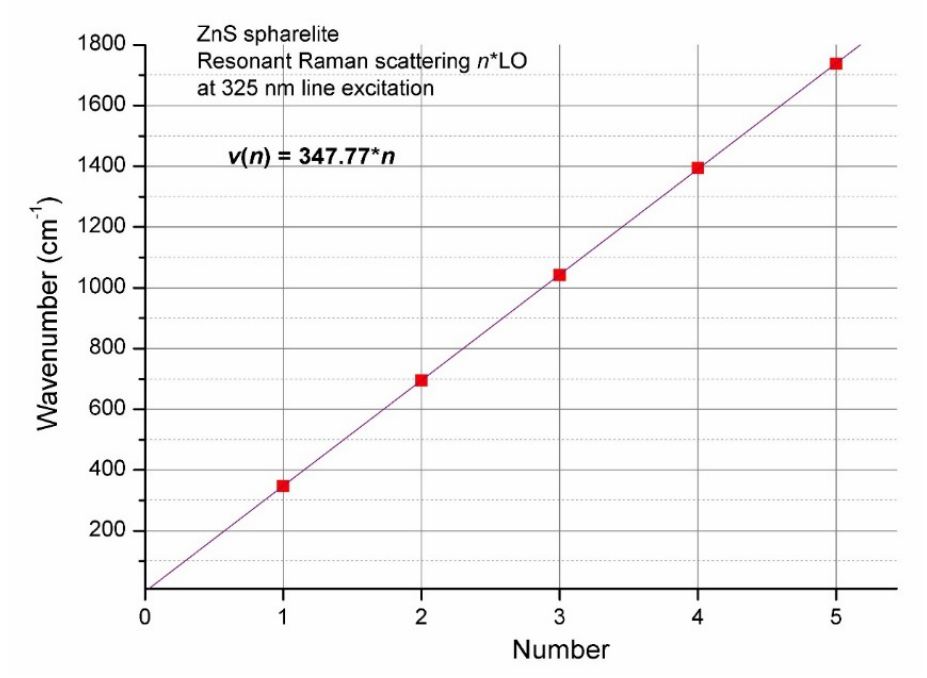
Figure 13. Wavenumber of strong bands ( n LO) in resonant Raman spectra of CM sphalerite, at 325-nm excitation, as a function of the number n of repeated basic tone reflections (LO mode 348 cm − 1 ).